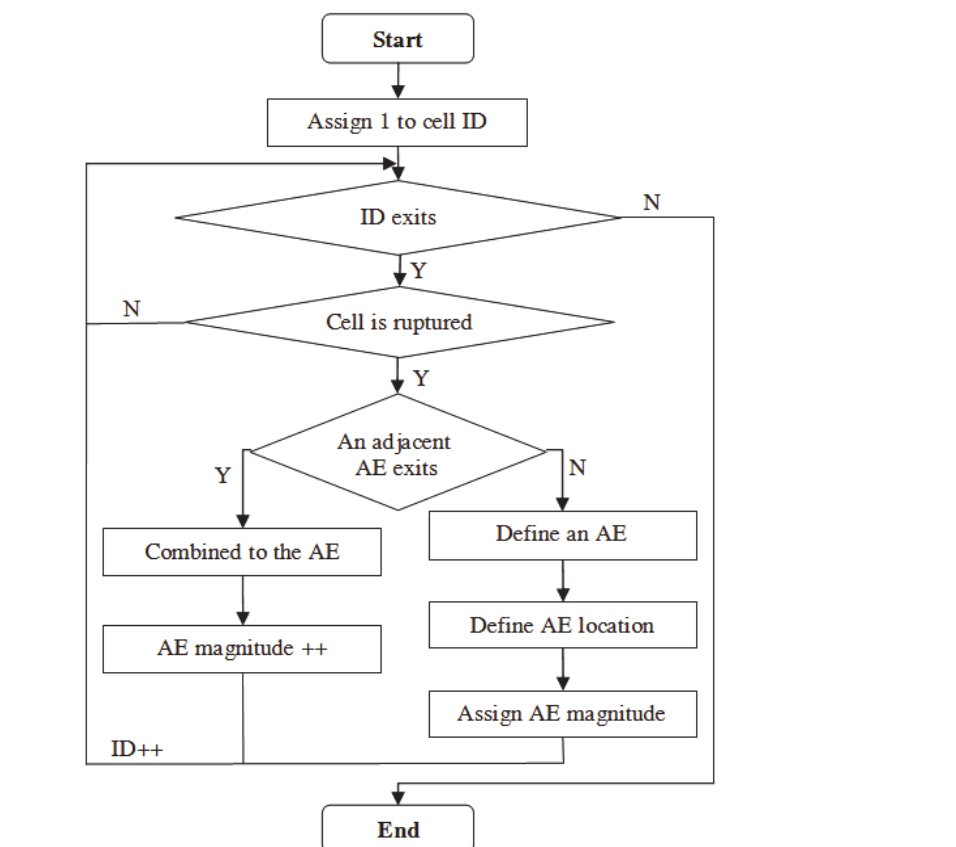
Figure 3: The flow chart of recording AE events.